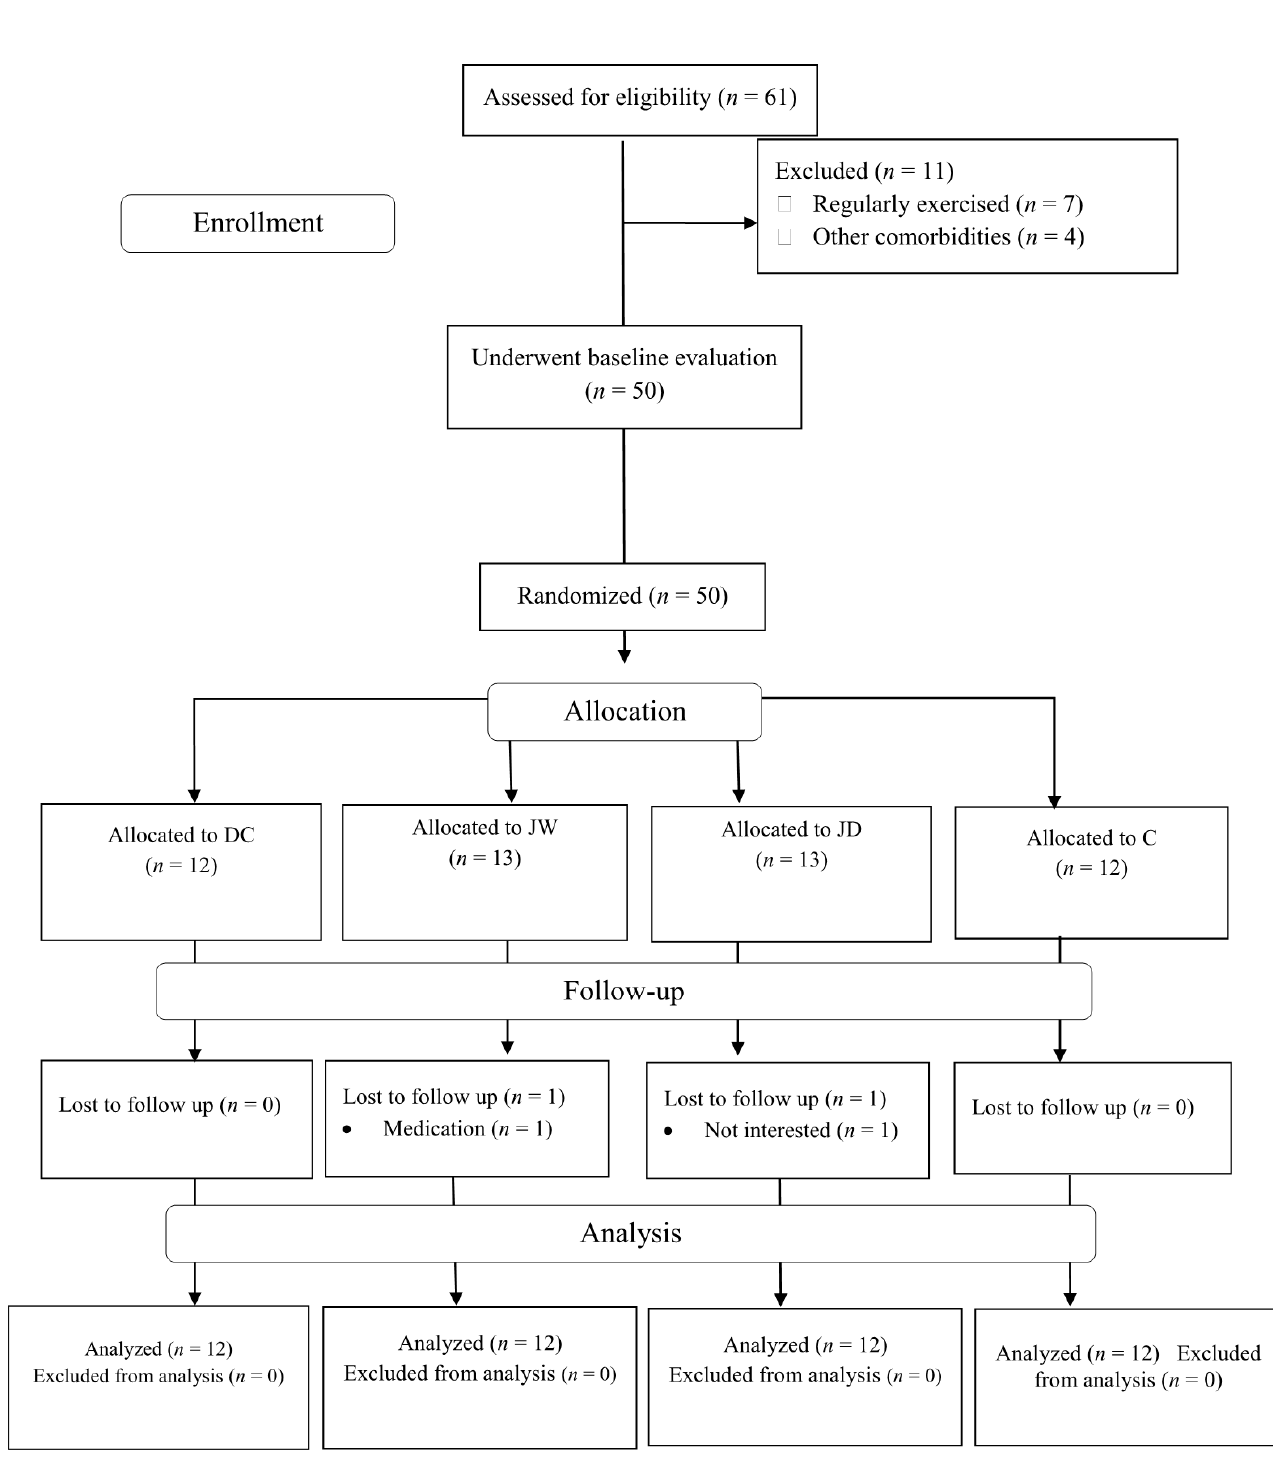
Figure 1. Participants flow diagram. Abbreviations: JW, jump rope exercise + white chocolate; JD, jump rope exercise + dark chocolate supplementation; DC, dark chocolate consumption; C, control.